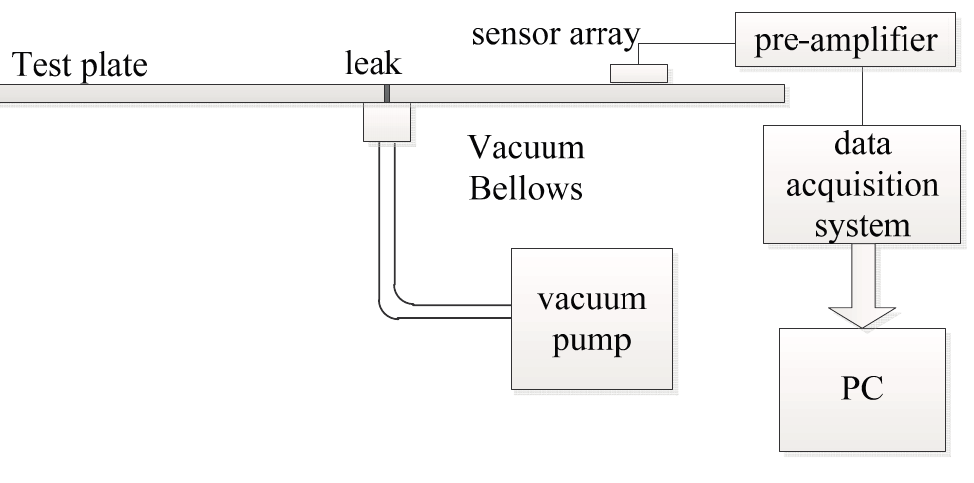
Figure 6. Experimental apparatus (schematic